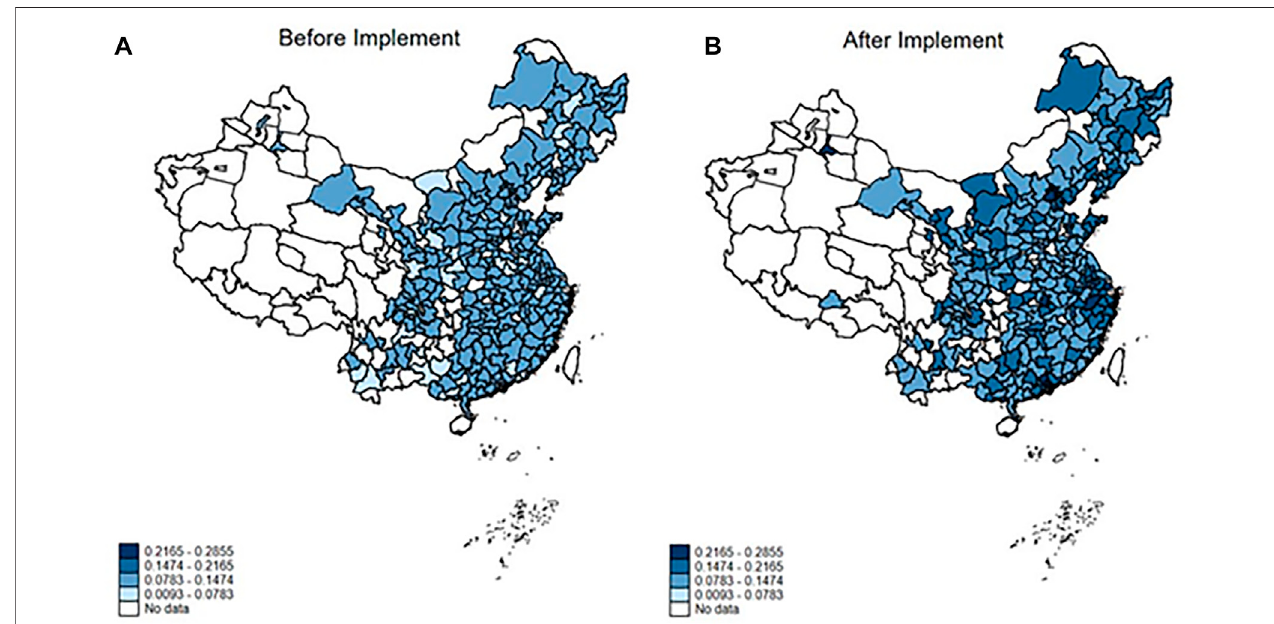
FIGURE 1 | Spatial distribution of green development before and after the implementation of STFP. (A) Green development level before the implementation of STFP; (B) Green development level after the implementation of STFP.